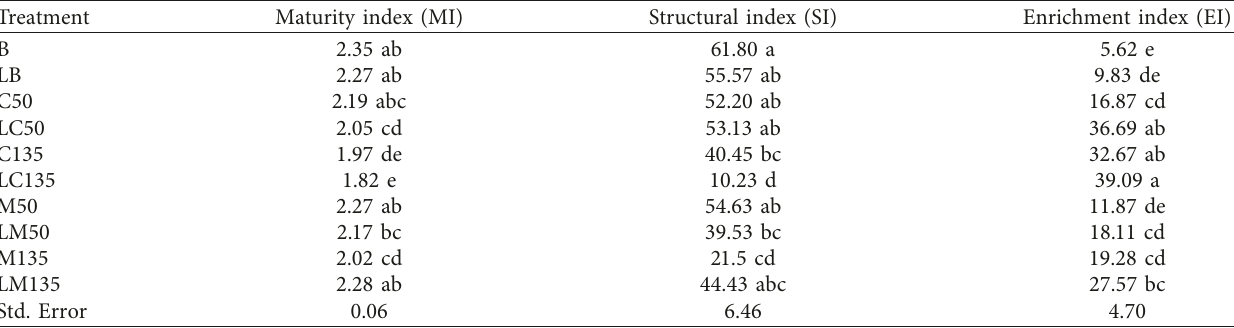
Table 2: Nematode community index values.